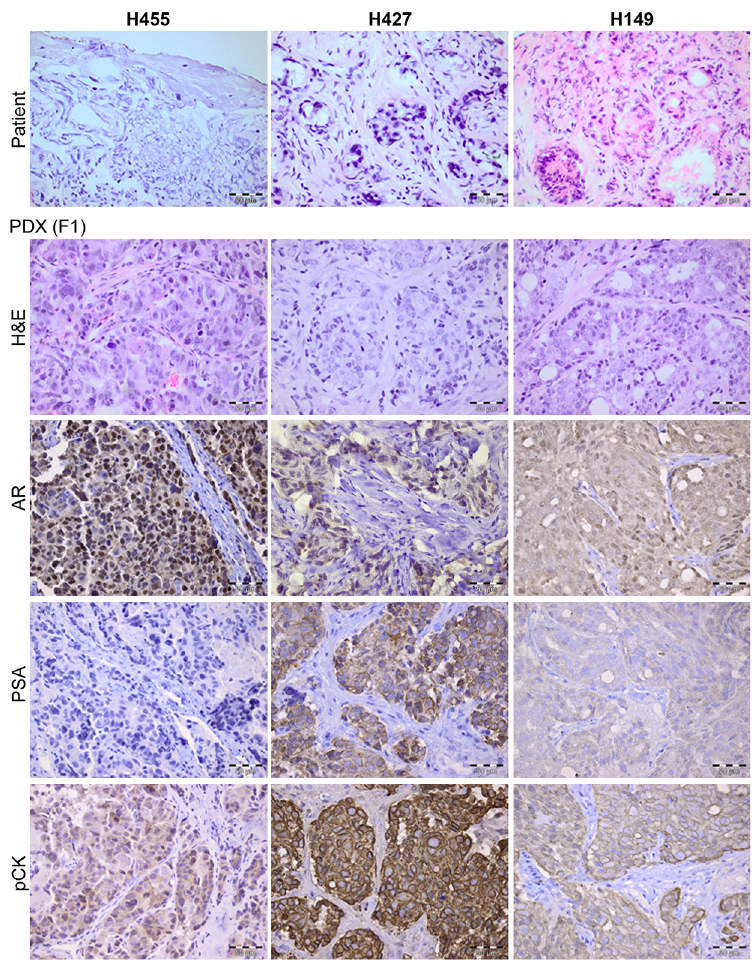
Fig 2. Primary tumour xenografts derived from human prostate tissue specimens demonstrating typical features of prostate adenocarcinoma. H&E sections of humandonor sample (upper panel)and corresponding xenograft(lower panel). Xenograft tissue sections were stained with antibodiesraisedagainst humanAR (clone441 at 1:50), PSA (1:25) and pan-cytokeratin (1:800). Human tissue, from patients with BPH or cancer was used as a positive control. Non-specific signal was assessedusing isotype controls and secondary only antibodies.Xenograft images are from primary outgrowths (annotatedas F1). Magnification